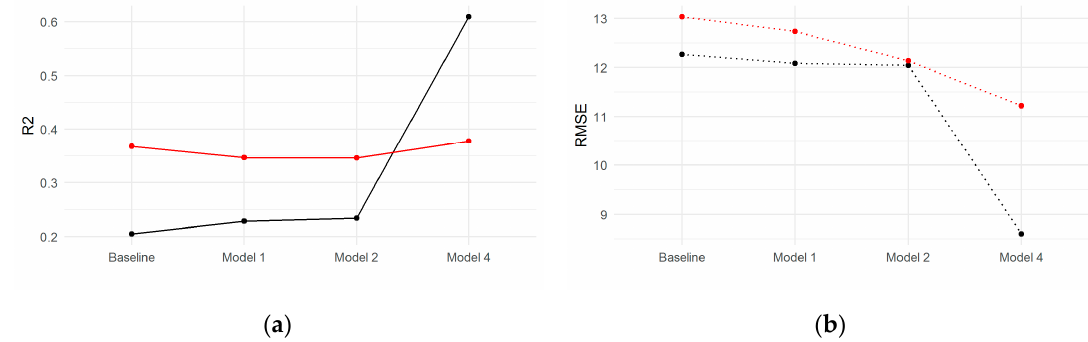
Figure 8. R 2 (( a ), solid) and RMSE (( b ), dotted) from the baseline linear and non-linear calibration models fitted on data from the long-term AQS-AERONET sites in Central Valley, CA, showing AOD-PM 2.5 models (black), and application to MISR AOD data (red).